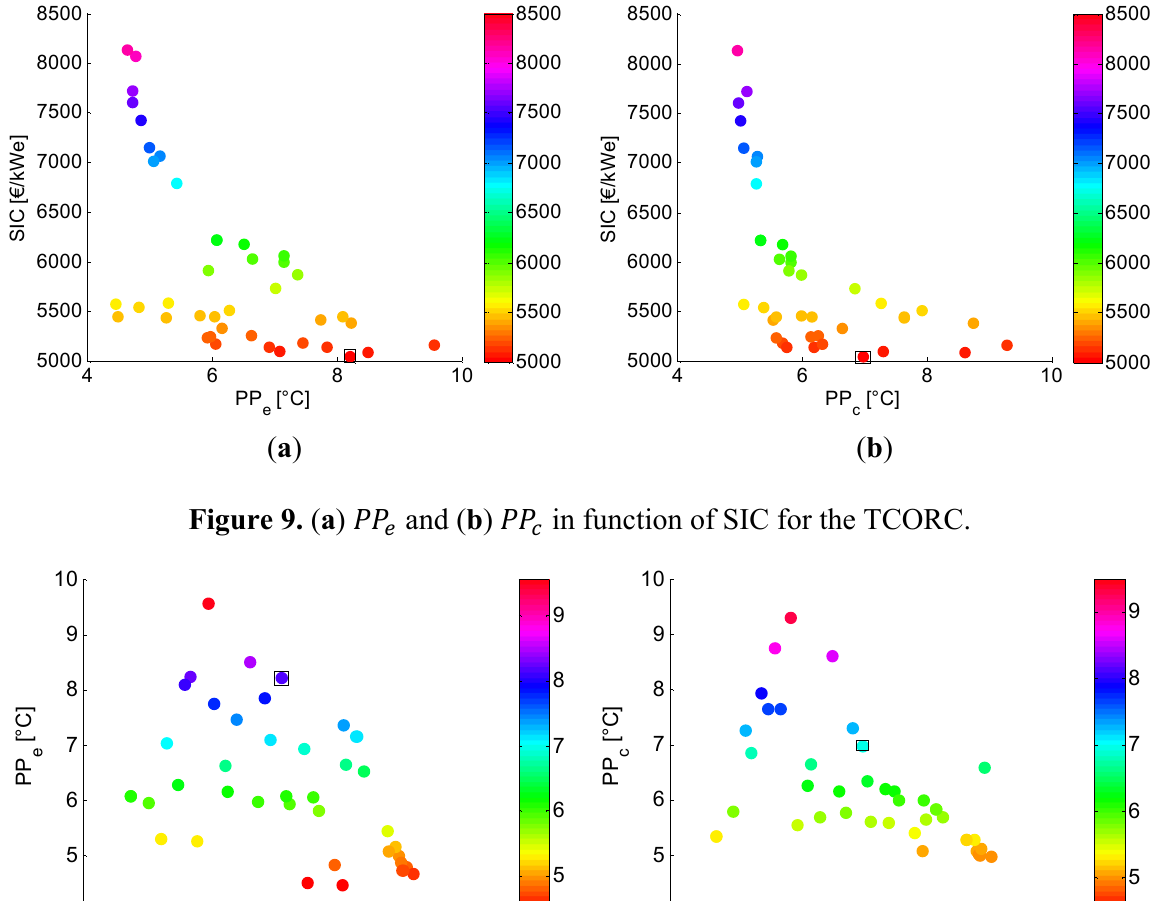
and ( b ) (cid:1842)(cid:1842) (cid:3032)